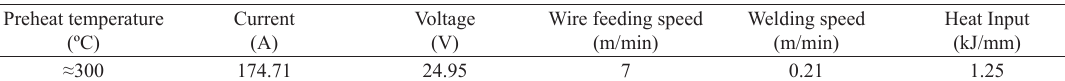
Table 7. Welding procedure parameters.